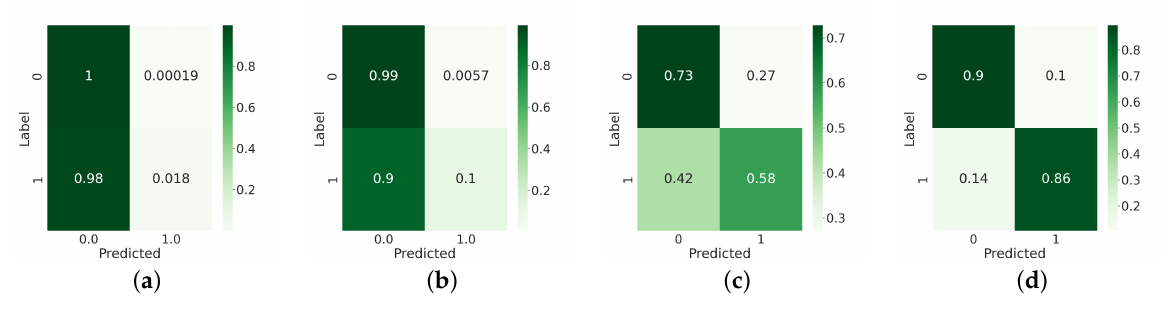
Figure 6. Confusion matrices of ( a ) RF PUL , ( b ) ENSEMBLE PUL , ( c ) OCSVM, and ( d ) PUL-SITS considering the case in which the land cover class of interest (the positive class) is Cereals/Oilseeds with the number of positive training data objects ( n ) equal to 80. Table 4. Performances in terms of the F-Measure of the different competing strategies when the land cover class of interest (the positive class) is Cereals/Oilseeds .